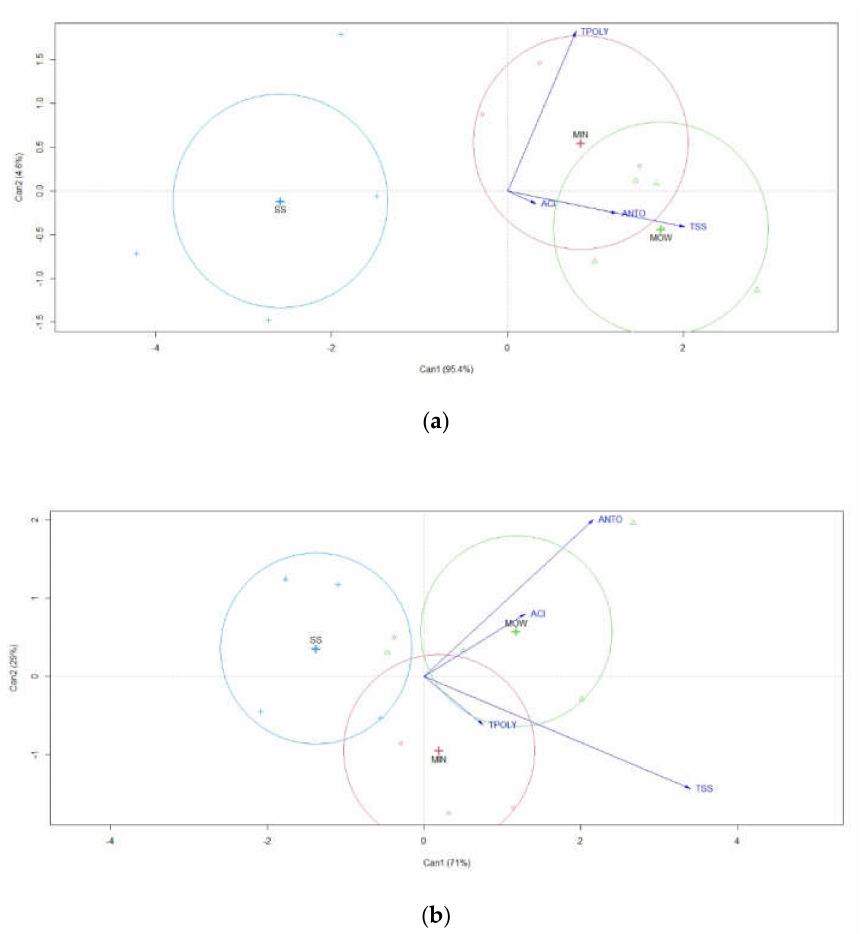
Figure 6. Discriminant canonical analysis of berry composition in 2020 ( a ) and 2021 ( b ). MIN: mineral; MOW: municipal organic waste compost; SS: sewage sludge compost; TSS: total soluble solid; ACI: acidity; TPOLY: total polyphenols; ANTO: anthocyanins.